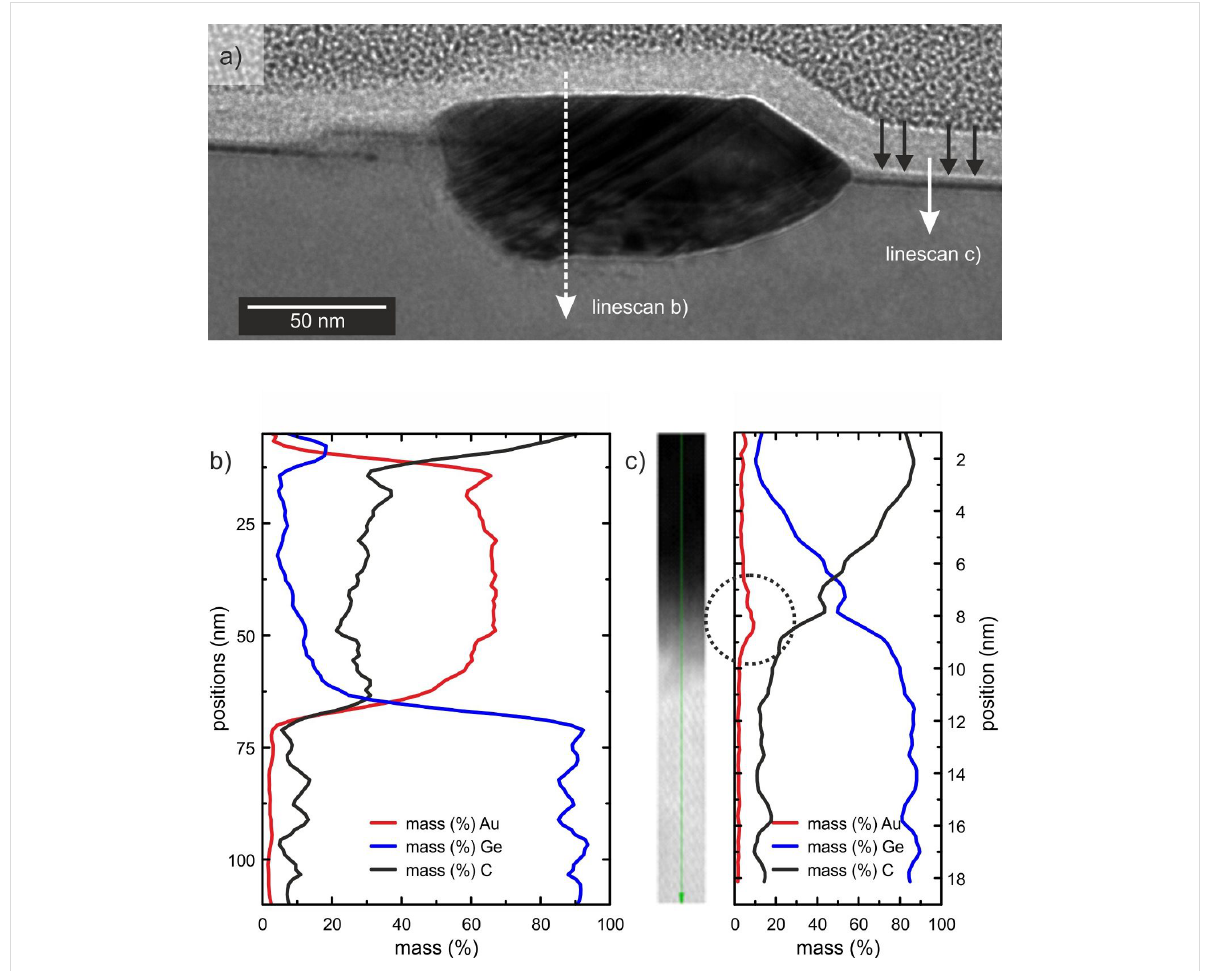
Figure 4: a) Exemplary TEM image of a lamella of Au grown on Ge(001) after the deposition of 6 ML of Au and annealing at 770 K. The apparent sample surface is exemplarily marked by black arrows on the right hand side of the image. b) EDX line scan analysis through the Au cluster. The Au cluster is reaching far into the Ge substrate. The non-zero Ge signal from the Au cluster is due to secondary fluorescence (excitations of “bulk” Ge caused by the X-ray emission from Au), which is a well-known effect (artefact) in the EDX spectroscopy. c) HAADF HRSTEM image through the Au/Ge lamella taken along the line on the right hand side in a). The results of the line scan EDX analysis are also shown. The Au concentration is found to reach its maximum of approx. 10% underneath the apparent sample surface (see circle). On the lower side of the image the atomic structure of Ge(001) bulk is